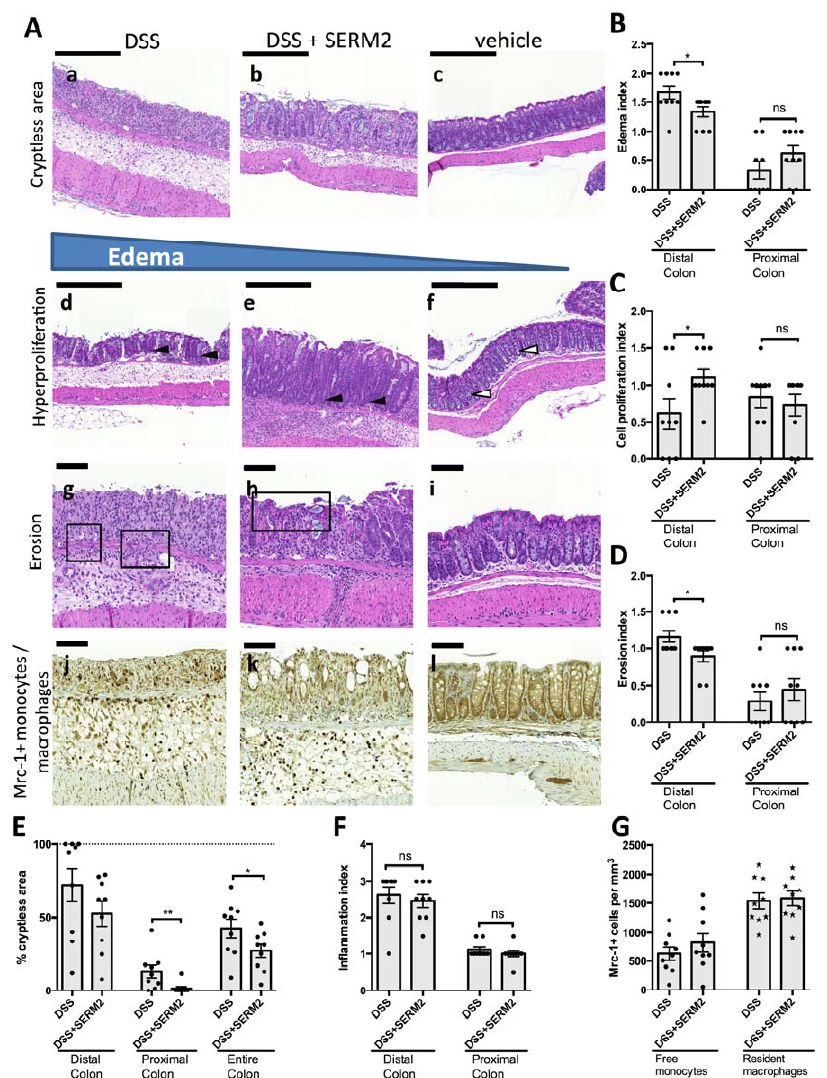
Figure 3. SERM2 inhibits colitis-associated tissue damages. ( A ) Representative longitudinal HE-stained sections of distal colon showing crypt loss of colon epithelium ( a – c ), loss of goblet cells, and increased crypt length as a signs of cell proliferation (black arrows) when compared to the vehicle (white arrows) group ( d – f ). In DSS mice ( g ), erosion (boxed area) extended through muscularis mucosae, whereas in DSS-SERM2 mice ( h ), only villi were a ff ected and vehicle samples ( i ) were intact. In Mrc-1 immunostained samples ( j – l ), Mrc-1-positive monocyte and macrophages were distributed throughout submucosa, but density of Mrc + + monocytes was the highest in DSS-SERM2mice. The e ff ect of SERM2 treatment is shown on ( B ) tissue erosion, ( C ) hyperproliferation, ( D ) size of edemas, ( E ) crypt loss, and ( F ) inflammation index in distal and proximal colon parts of DSS-challenged mice. ( G ) The e ff ect of SERM2 on Mrc-1 + monocyte and macrophage (brown) densities in colon submucosa. B–G expressed as the mean ± SEM. Statistical significance calculated with unpaired t -test with equal SD’s. * p < 0.05; ** p < 0.01; *** p < 0.001. Scale bar 200 µ